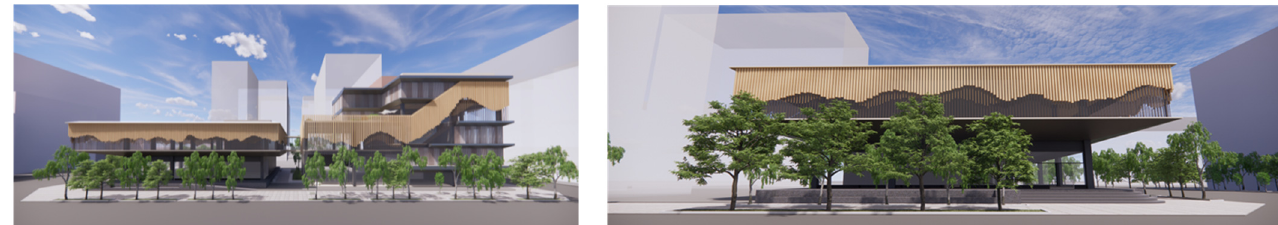
Figure 6. The final decision façade of headquarters (Participant A).